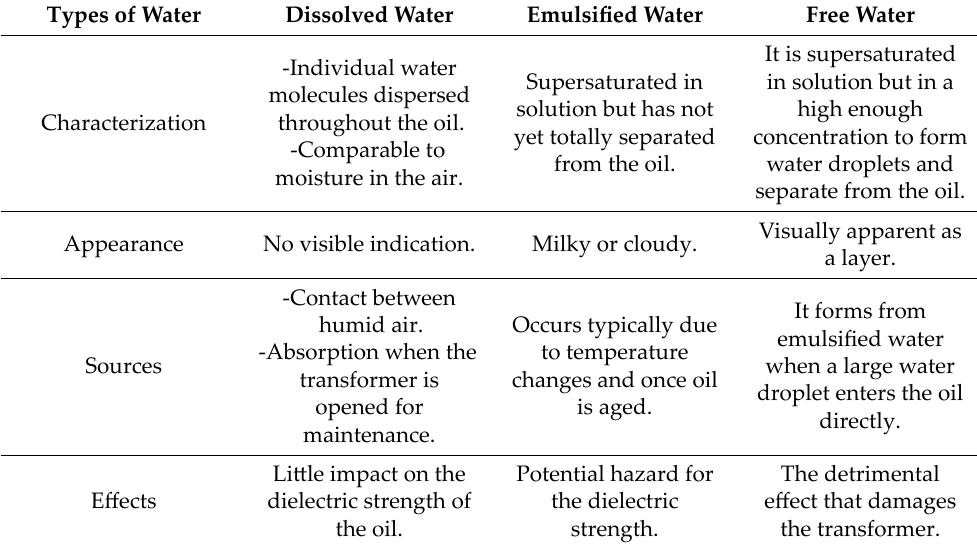
Table 1. Properties of water that exist in transformer